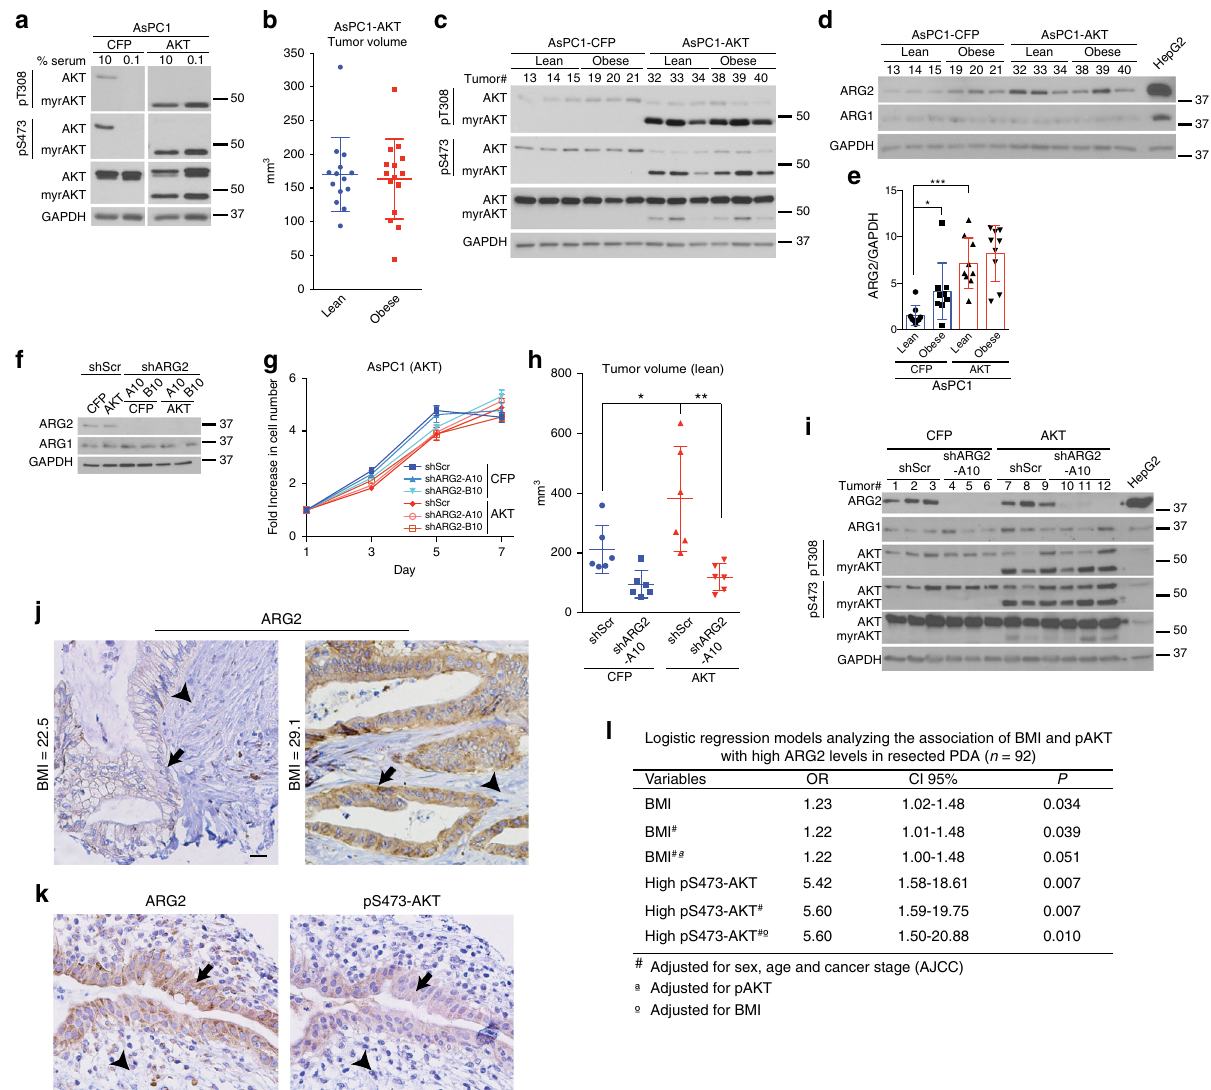
Fig. 6 AKT activation enhances in vivo PDA growth and sensitizes tumors to ARG2 knockdown. a Immunoblots for pT308-AKT, pS473-AKT and total AKT in isogenic AsPC1-CFP and AsPC1-AKT PDA cells expressing SRC myristoylation sequence-AKT fusion (myrAKT). b Volumes of orthotopic PDA tumors from cells in a (10 5 per mouse) grown for 6 weeks in lean ( n = 14) or obese ( n = 15) 12 – 14 week old male Rag1 − / − mice following the outline in (Fig. 1a). c , d Immunoblots for pT308-AKT, pS473-AKT, and total AKT c , ARG2 and ARG1 d in tumors from b . e ARG2 levels as quanti fi ed by ImageJ and normalized to GAPDH, from immunoblots in d , Fig. 1e, and Supplementary Fig. 10c. f Immunoblots of ARG2 and ARG1 in isogenic cells from a , harboring control Scramble (shScr) or ARG2 (shARG2) knockdown. g Proliferation curves of cells in f ( n = 6). Data are representative of four independent experiments. h Volumes of orthotopic PDA xenografts from cells in f that were injected in lean 8 – 9 week old male Rag1 − / − mice (500,000 per mouse) and grown for 5 weeks ( n = 6). i Immunoblots for ARG2, ARG1, pT308-AKT, pS473-AKT and total AKT from representative tumors in h . j , k Representative immunohistochemistry staining showing enhanced ARG2 levels in PDA tumors from patients with higher compared to lower BMI j , and overlapping pS473-AKT and ARG2 staining in sequential tumor sections from PDA patients k . Arrows indicate areas of ductal adenocarcinoma and arrowheads indicate stroma. Scale bars : 20 µ m. l Multivariate regression analysis of the association of BMI and pAKT with high ARG2 levels in resected PDA immunostained in j , k . OR odds ratio, CI con fi dence interval, AJCC American Joint Committee on Cancer. Data represent the mean ± s.d. in b , e , h